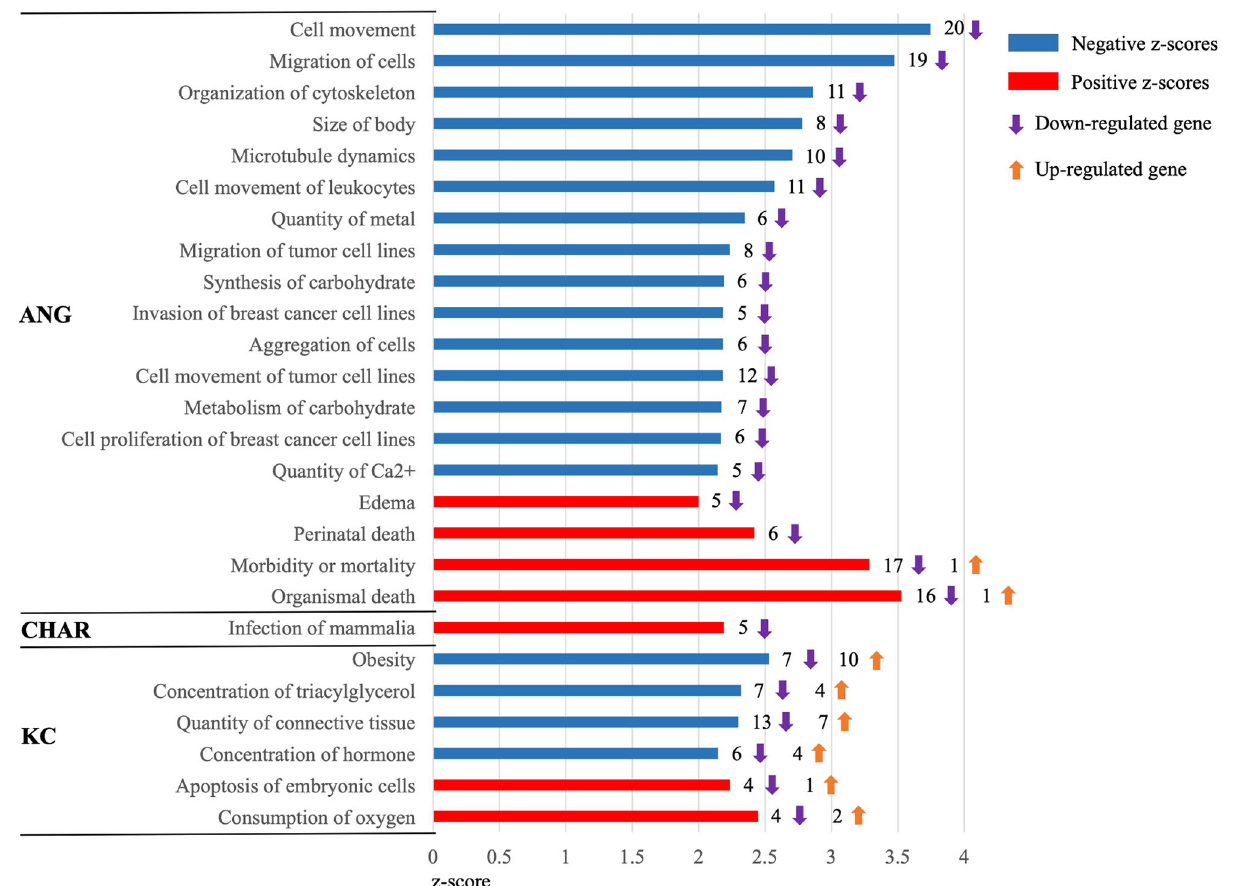
Figure 3. Functional classification of differentially expressed genes using IPA (Ingenuity Pathway Analysis) in different breeds of beef cattle. Positive z-scores are indicated with red bars and negative z-scores with blue bars. A positive z-score (2) indicates an increased predicted activation state, while a negative z-score (− 2) indicates a reduction in function. The number to the right of the bar is the number of differentially expressed (DE) genes. Up arrow and down arrow represent the DE genes up- and down-regulated in L-RFIfat compared to H-RFIfat steers, respectively. ANG, Angus; CHAR, Charolais; KC, Kinsella